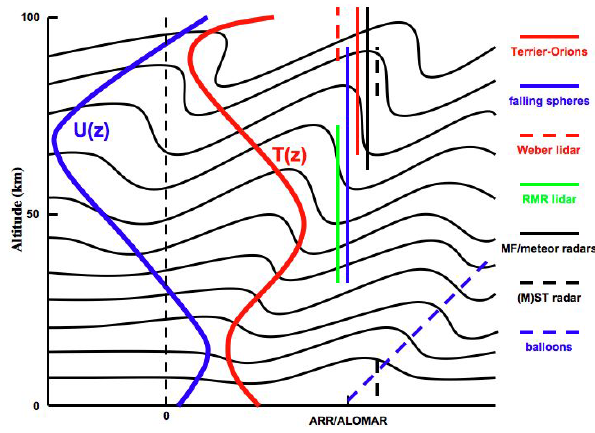
Fig. 1. Artist’s representation of the MaCWAVE summer program. The WEBER lidar refers to the Na lidar at